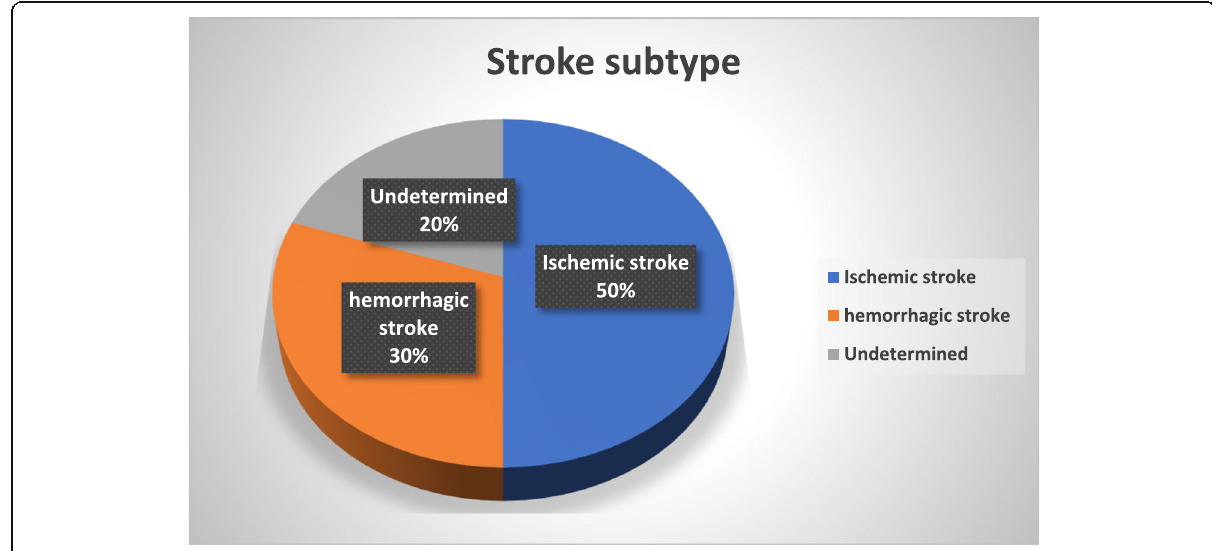
Fig. 1 Distribution on the types of stroke in the medical ward of Debre Markos Referral Hospital, Northwest Ethiopia, 2017 –